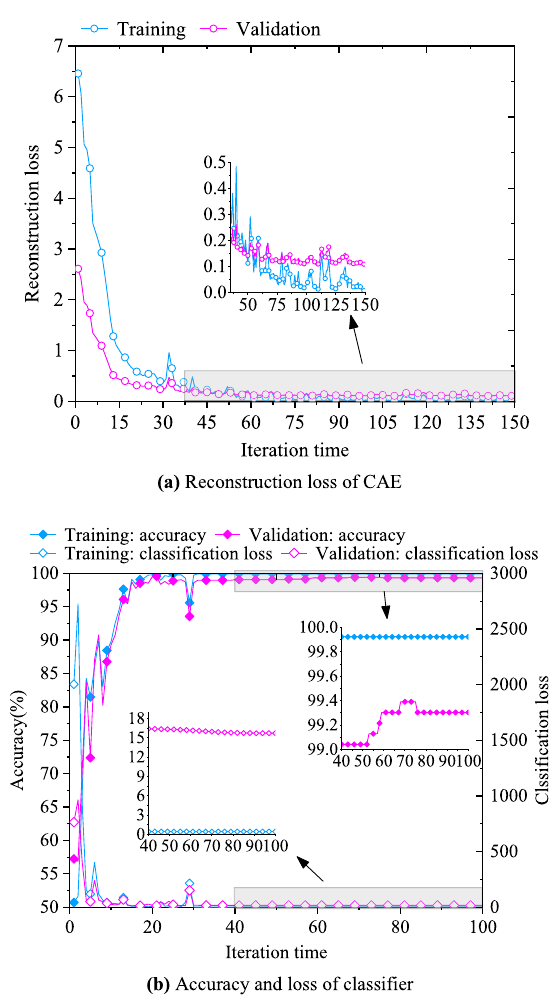
Fig. 13 Training and validation results